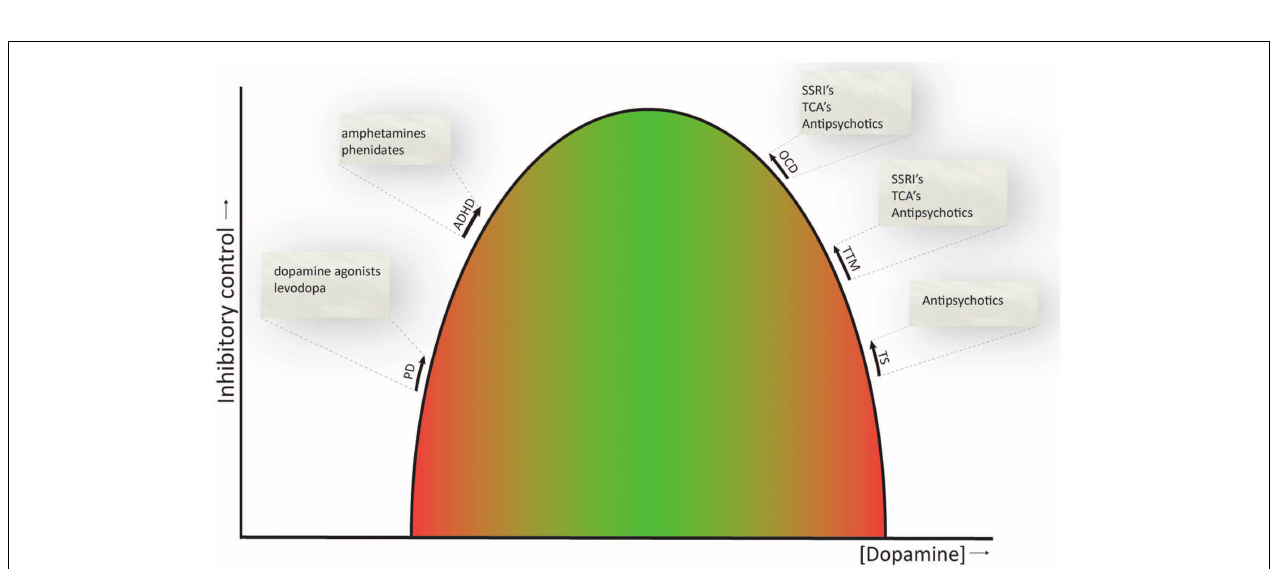
used to treat the symptoms of these disorders are listed and are thought to normalize dopamine levels and thereby ameliorate response inhibition (indicated by the arrows). PD, Parkinson’s disease; ADHD, attention-deficit hyperactivity disorder; OCD, obsessive–compulsive disorder;TTM, trichotillomania;TS,Tourette’s syndrome. NB. Since comparison studies across OCD,TTM, andTS are in short supply, the spacing between these disorders on the U -shaped curve is arbitrary and does not necessarily represent actual differences in dopamine levels between these